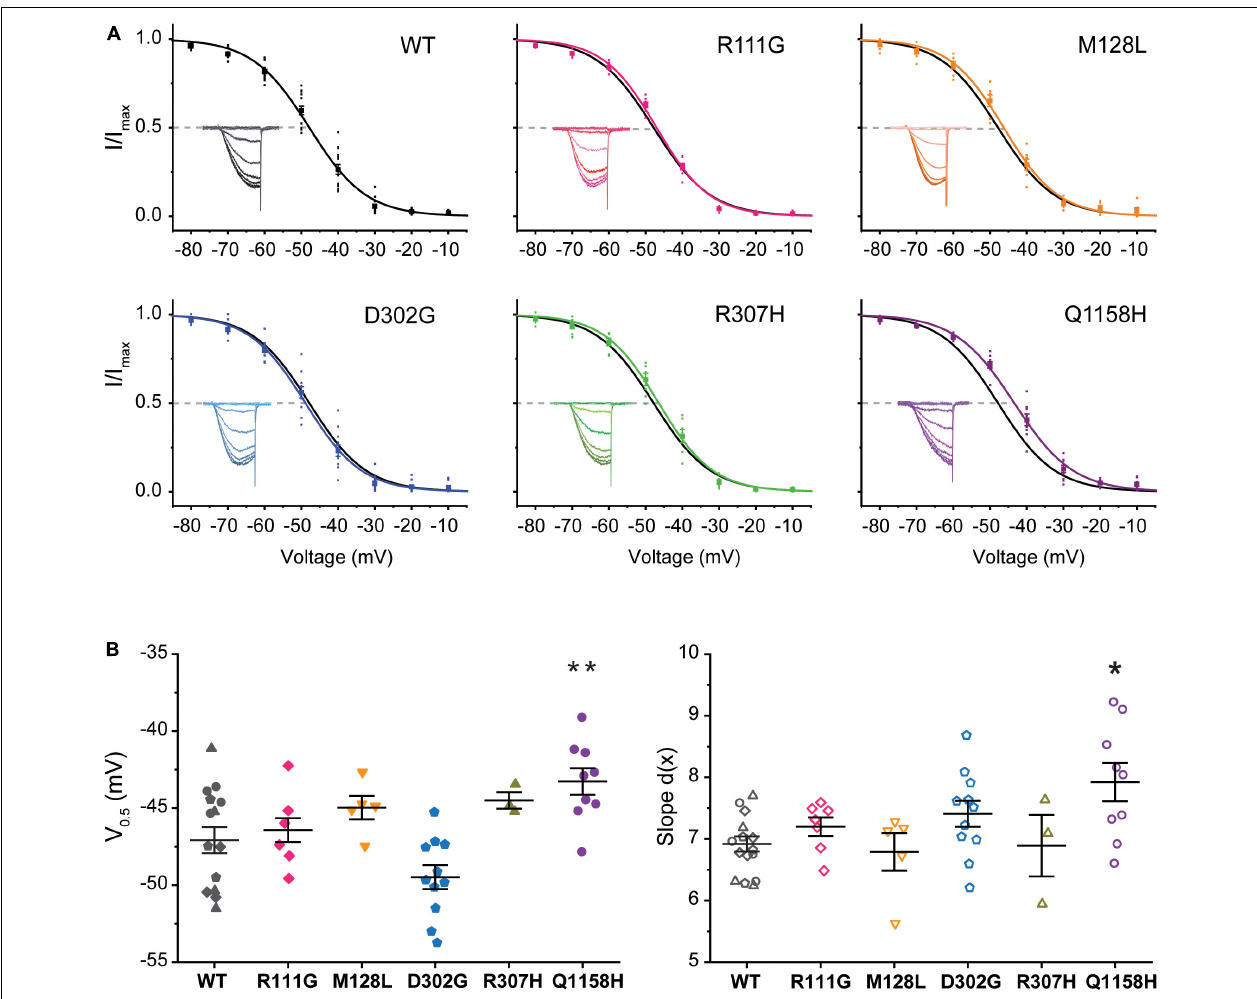
FIGURE 3 | Steady-state inactivation (SSI) of HM-associated Cav3.3 variants. (A) Availability plots were constructed from normalized peak currents (I/I max ) vs. the inactivating pre-pulse potential. Representative SSI current traces for each channel variant are shown in the insets. Gray dotted lines indicate the potential at which 50% of the channels are inactivated (inact V 0 . 5 ). (B) SuperPlots summarizing SSI V 0 . 5 and slope [d(x)] for all variants. 0.001 < p < 0.01 (**), 0.01 < p 0.05 (*).